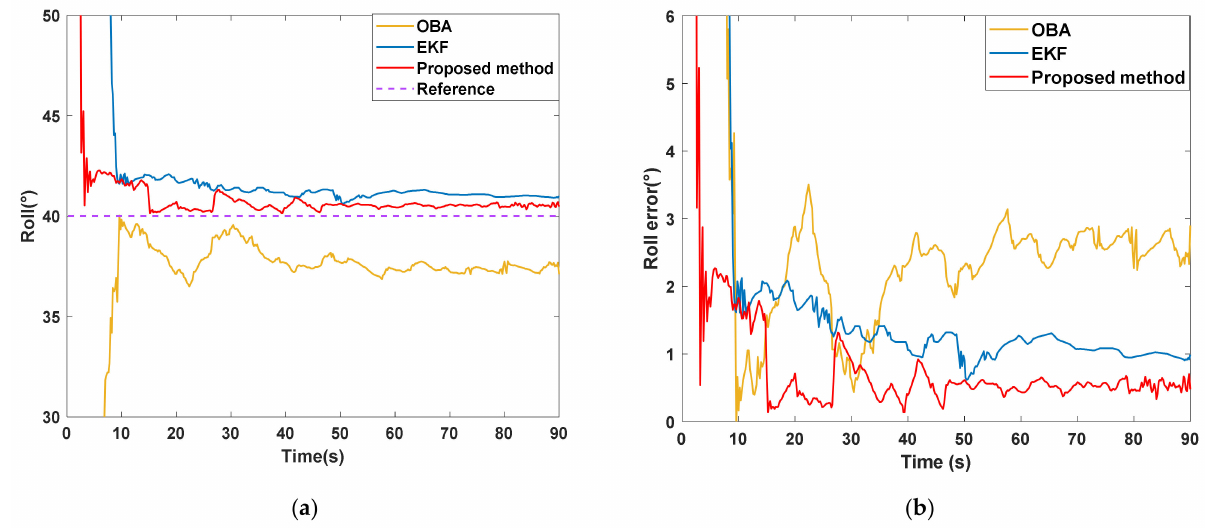
Figure 9. Simulation results of roll angle alignment with different alignment methods. ( a ) Roll an‑ gle alignment results of different alignment methods; ( b ) absolute value of roll alignment error of different alignment